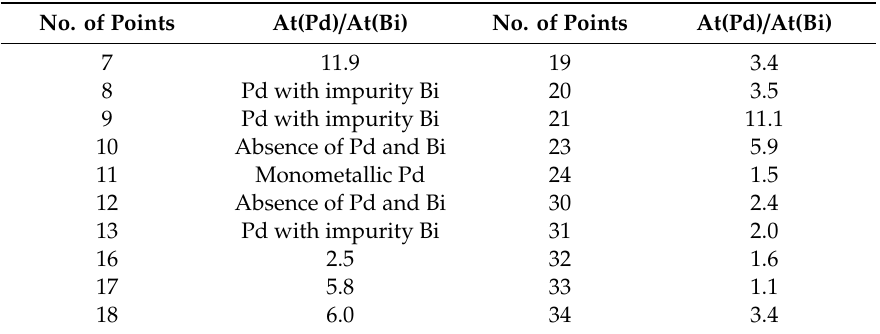
Figure 6. Pointlike scanning of the surface of the catalyst Pd → Bi / Al 2 O 3 by EDS at ( a ) 2,500,000 × magnification and ( b ) 2,000,000 × magnification. Table 2. Atomic ratio of Pd / Bi at the scan points of the sample surface of the catalysts PdBi / Al 2 O 3 and Pd → Bi / Al 2 O 3